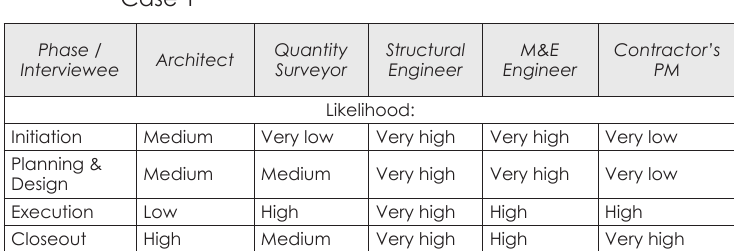
Perceptions regarding project risk P-I across the PLC in Case